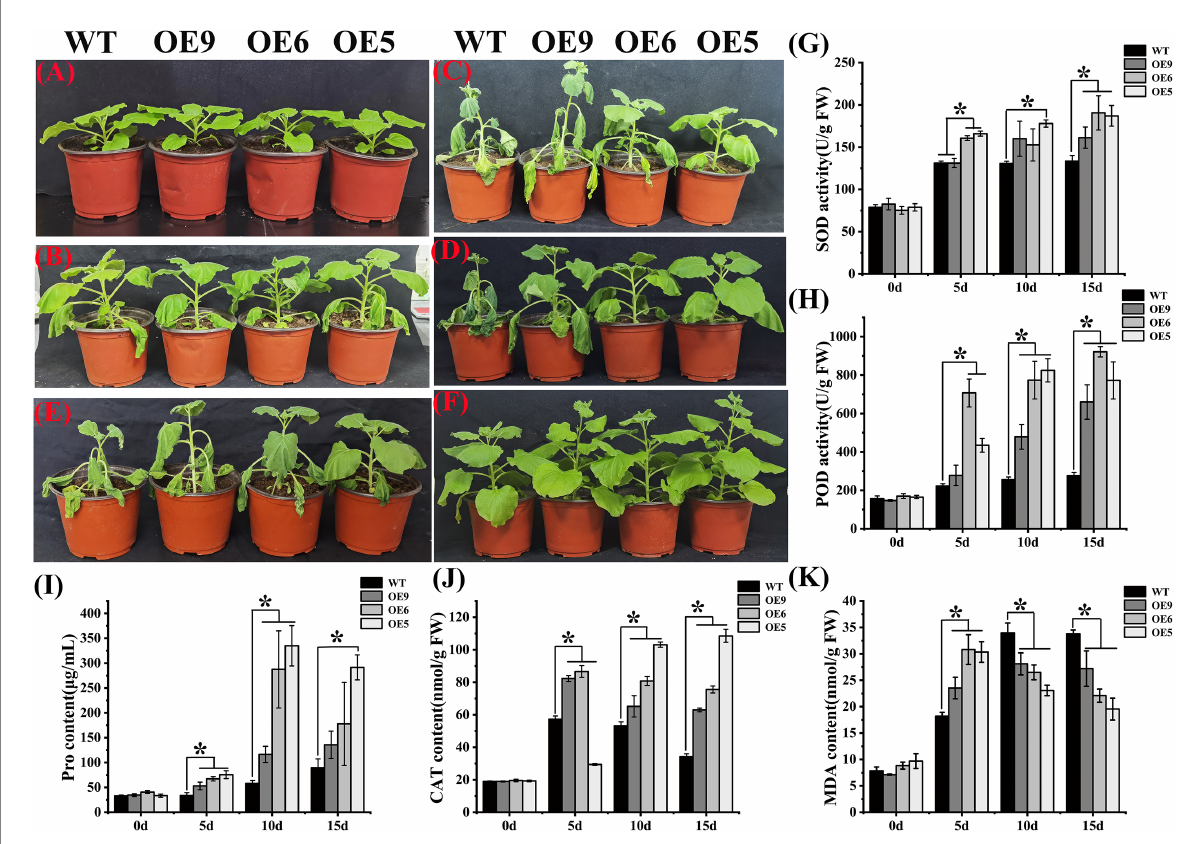
FIGURE 5 WT and OE tobacco lines are under drought treatment. (A–D) Phenotypes of tobacco drought treatments at 0, 5, 10, and 15 d. (E) Tobacco state after rehydration for 7 days after drought treatment. (F) Tobacco is grown normally for 15 days. (G–K) Determination of SOD, POD, Pro, CAT, and MDA contents in tobacco under drought treatment. * represent the significant differences of three replicates as determined by SPSS software ( p <